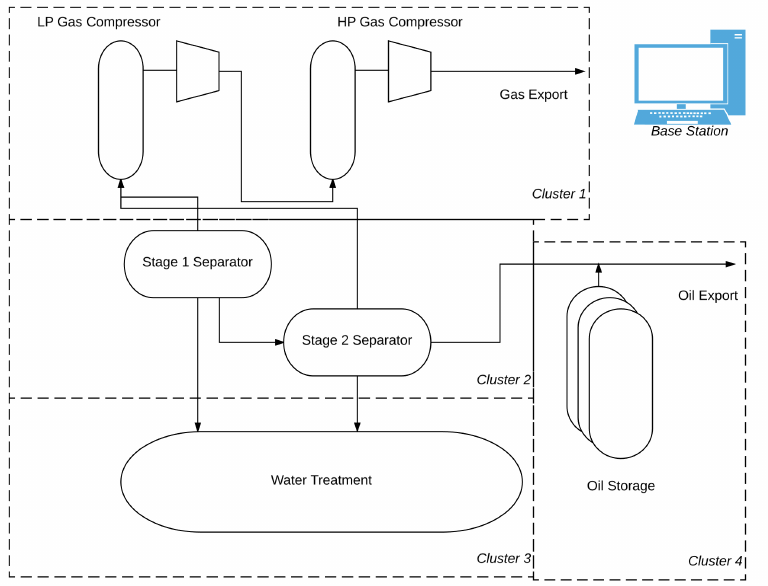
Figure 8. WSN for oil and gas refinery applications